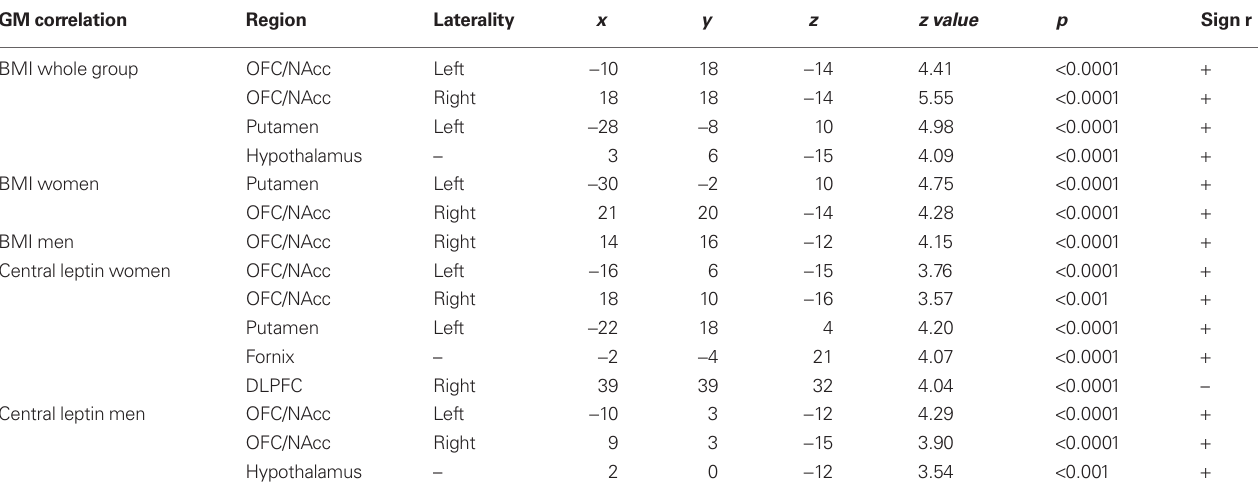
Table 1| Correlations between gray matter and measures of obesity. gM correlation